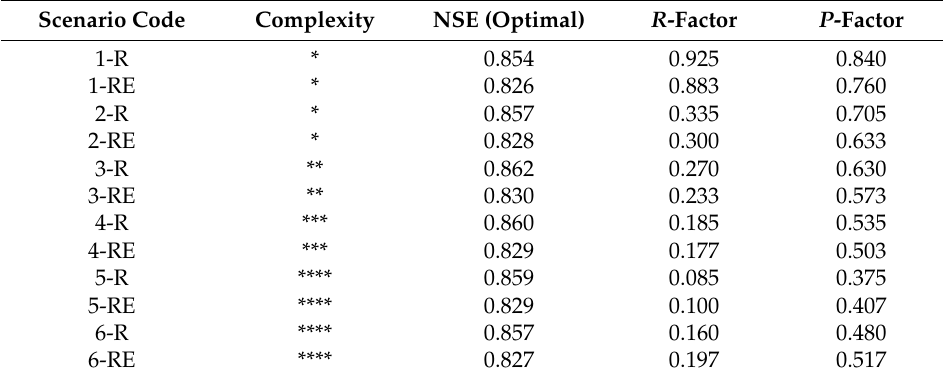
Table 4. Complexity, model performance, and uncertainty of di ff erent